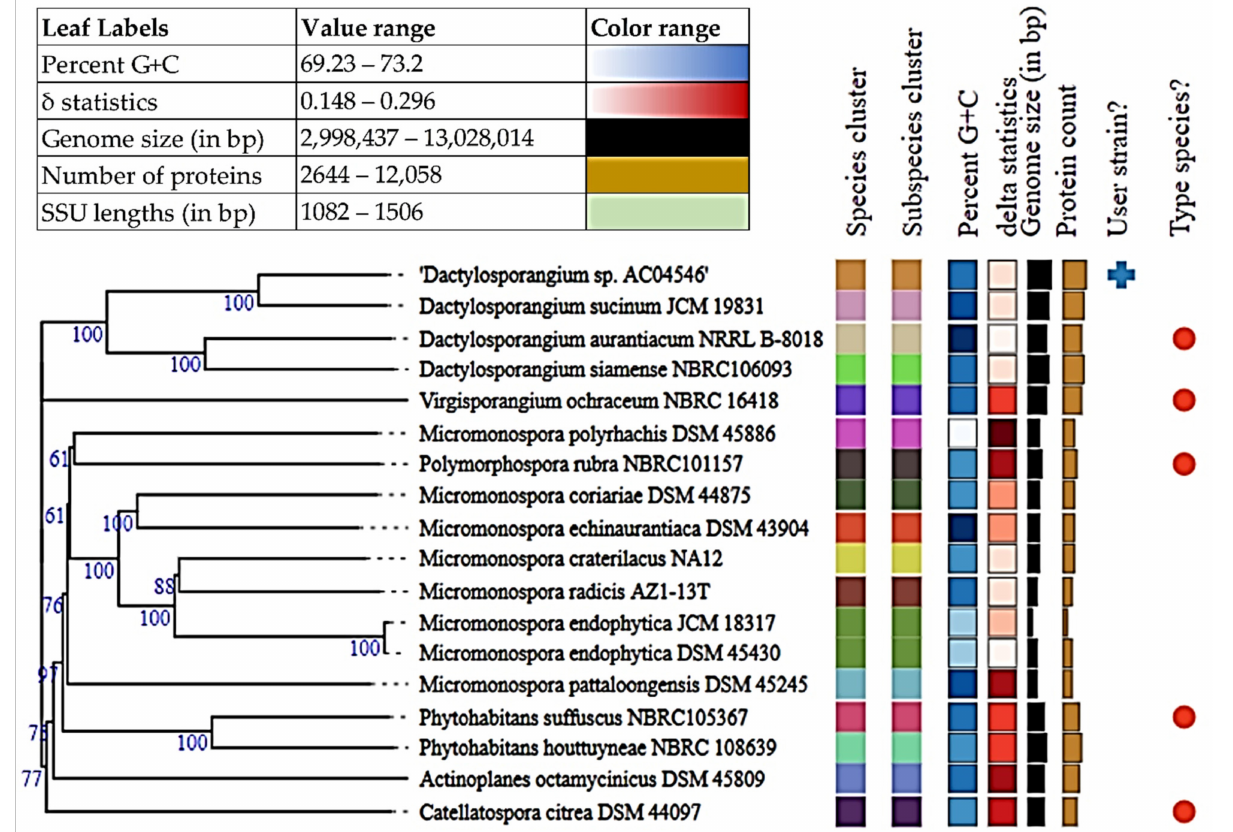
Figure 5. Tree inferred with FastME 2.1.6.1 (Lefort et al., 2015) from GBDP distances calculated from genome sequences. The branch lengths are scaled in terms of GBDP distance formula d5. The numbers above branches are GBDP pseudo- bootstrap support values > 60% from 100 replications, with an average branch support of 81.9%. The tree was rooted at the midpoint